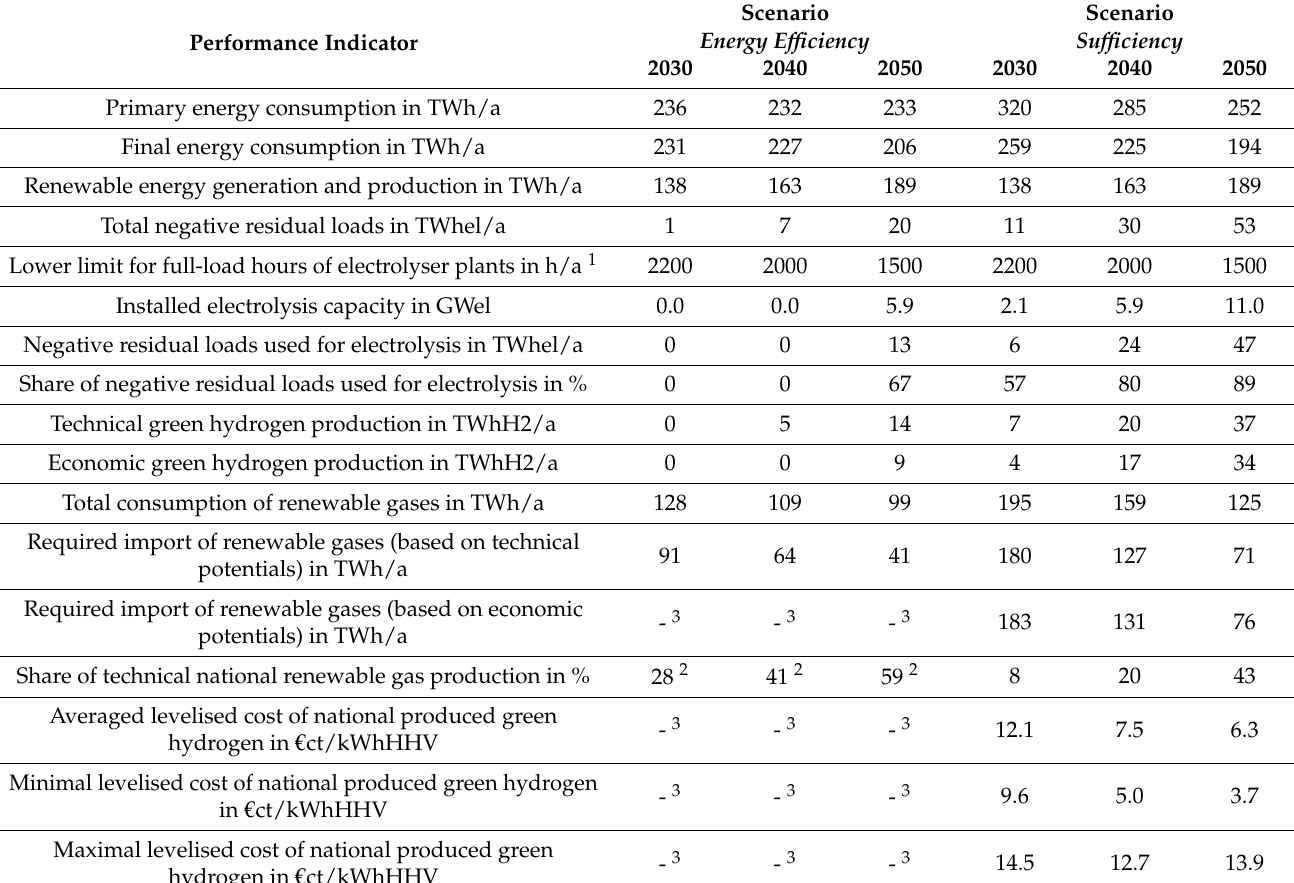
Table 5. Overview of the performance indicators for both scenarios and all considered